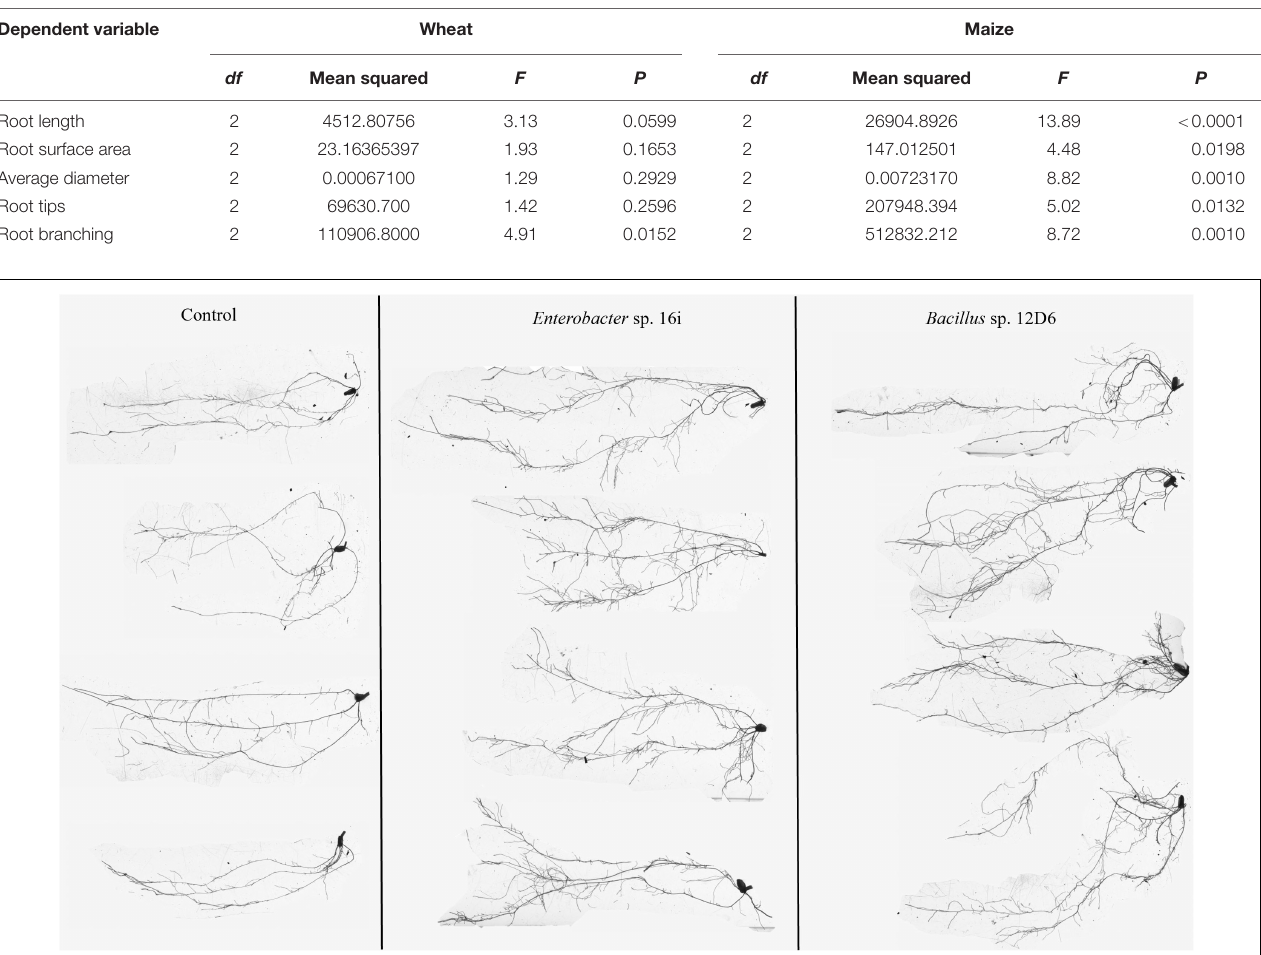
TABLE 1 | Analysis of variance (ANOVA) for the effect of plant growth-promoting rhizobacteria (PGPR) treatment on wheat and maize root systems following a 7-day water deficit. Dependent variable Wheat Maize